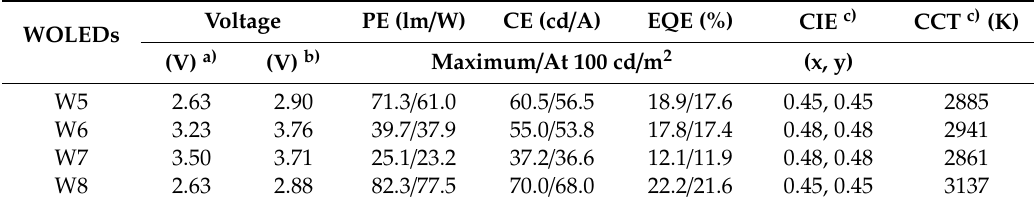
Table 2. Summary of voltages, power e ffi ciency, current e ffi ciency, EQE, CIE, and CCT for devices W5 to W8. a), b) Voltages were measured corresponding to the onset and 100 cd / m 2 . c) CIE and CCT were tested at 100 cd / m